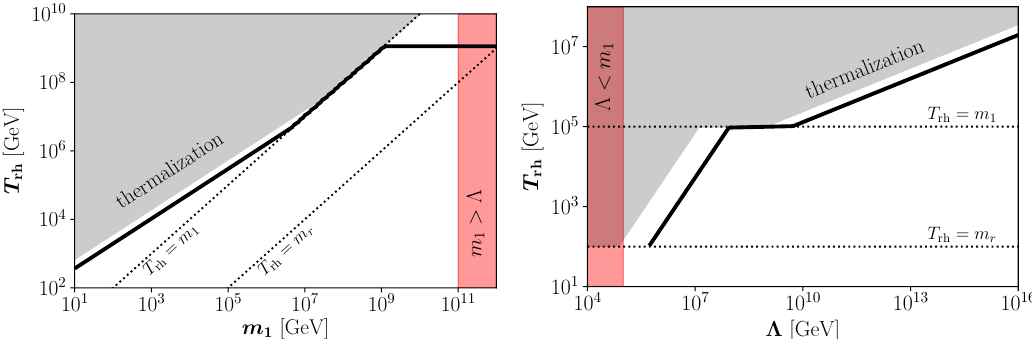
Figure 3 . Sequential freeze-in via annihilations: Reheating temperature required to reproduce the experimentally observed DM abundance, (cid:10) (cid:31) h 2 , for m (cid:31) = 1 MeV. Left panel: T rh as a function of m 1 for (cid:3) = 10 11 GeV; right panel: T rh as a function of (cid:3) for m 1 = 10 5 GeV. In both panels, the radion mass is m r = m 1 = 10 3 . The gray-shaded areas are the regions where chemical equilibrium with the SM is reached (and freeze-in does not occur), whereas the red-shaded areas are the regions where m 1 > (cid:3) and the EFT approach breaks down. Eventually, the two black-dotted lines give a visual understanding of the di(cid:11)erent regions in eq.